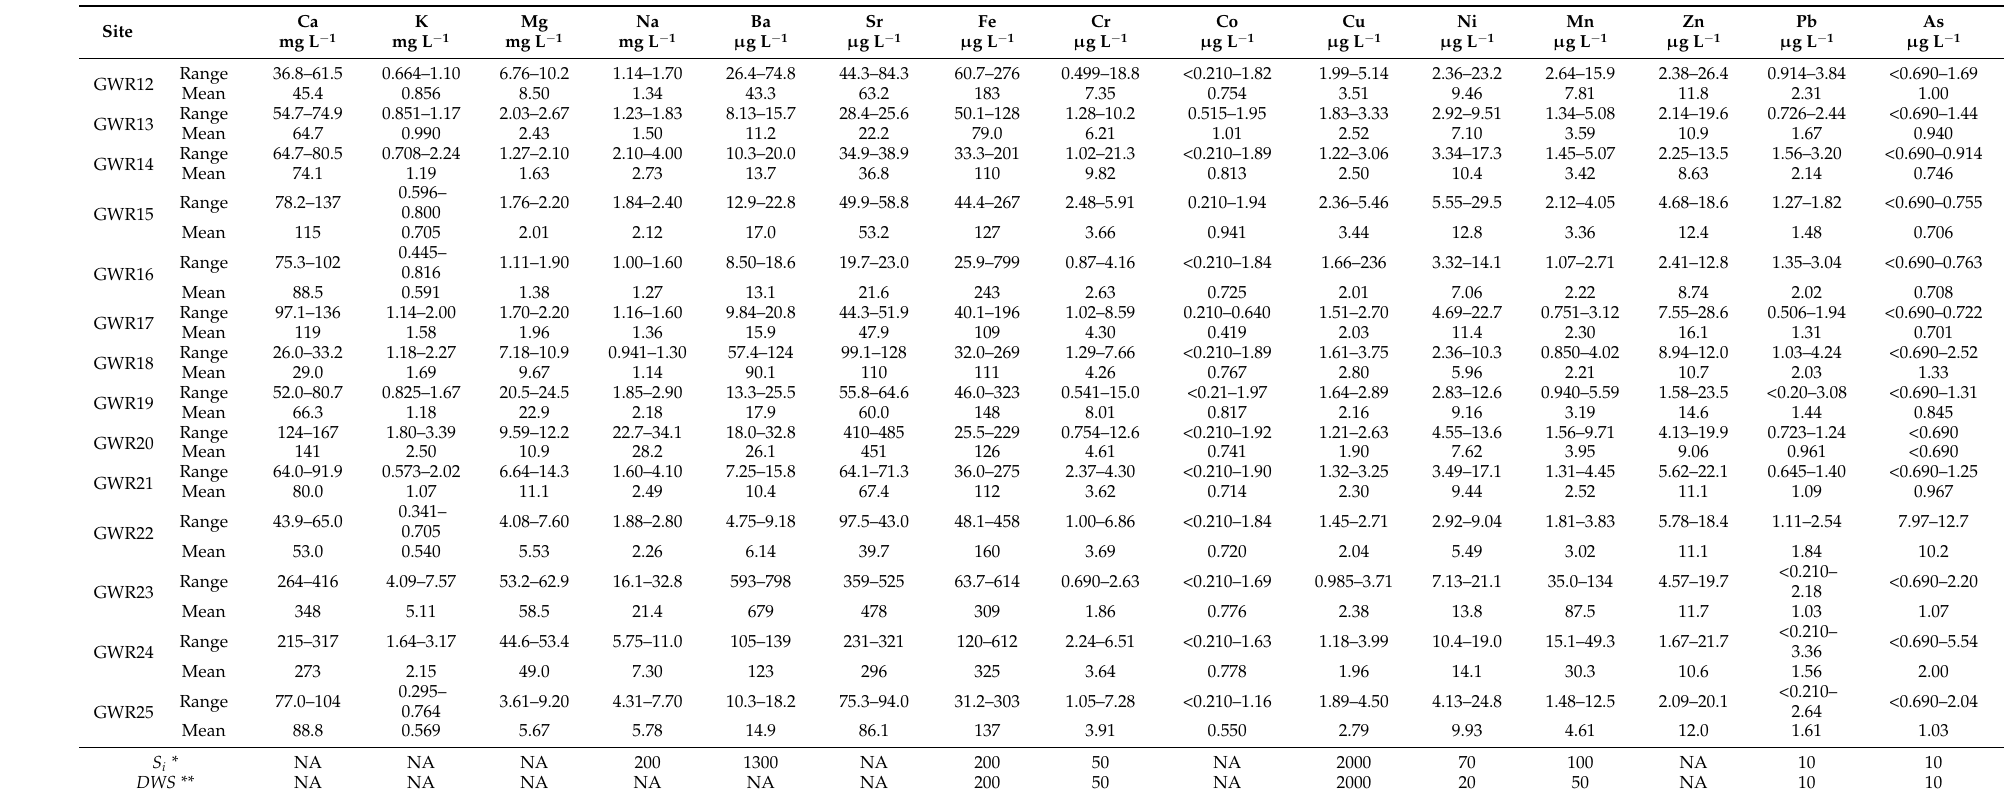
Table 4. Range and mean values of major and trace elements in karst